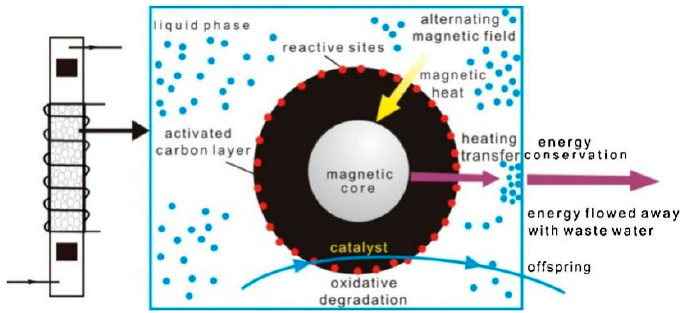
Figure 17. Energy conversion process of catalyst particles in iHR [98].